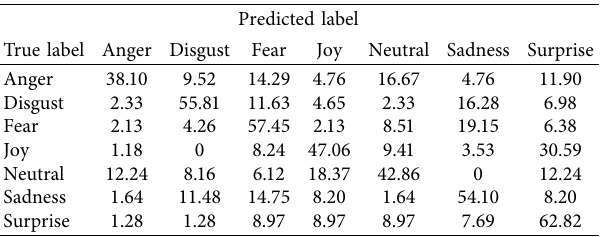
Table 5: Confusion matrix. Predicted label